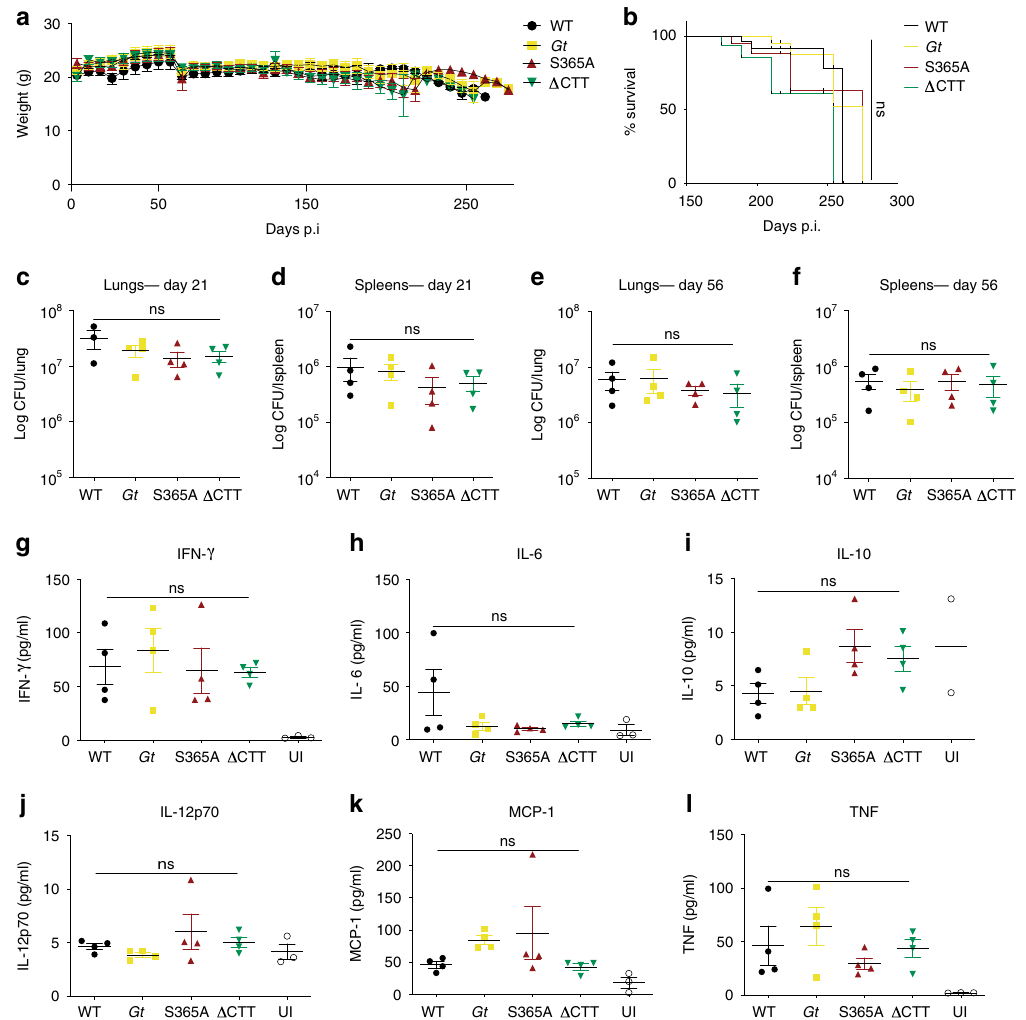
Fig. 2 STING mutant mice exhibit normal susceptibility to M. tuberculosis infection. Mice were aerosol infected with 400 CFU dose of M. tuberculosis (Erdman strain) and a weighed every week. b Survival of infected mice. c Bacterial burden from lungs and d spleens at 21 and e , f 56 days post infection. g – l Cytokine levels in the lungs from infected mice at day 21, measured by CBA. All mice except C57BL/6J WT were bred in-house. a , b n = 12 mice per genotype. c – f n = 4/4/4/4. g – l n = 4/4/4/4/3. Representative results of fi ve independent experiments, each yielding similar results. UI, uninfected. Center and error bars show mean and SEM. Analyzed with one-way ANOVA and Tukey post test. ns not signi fi